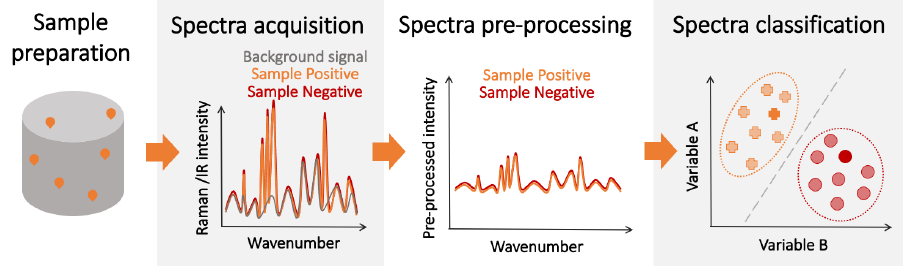
Figure 3. An example of the detection process for a spectroscopy-based detector. After sample collection, the sample is prepared to be analyzed. This preparation, which can be minimal, depends on the spectroscopic technique, type of sample, and probing mechanism. The prepared sample is measured, and its spectrum is obtained. The spectrum is then classified as positive or negative depending on the pre-build classification model. Oftentimes, pre-processing (e.g., background subtraction) of the raw spectrum is necessary. The final outcome is a decision (i.e., positive/negative), which depends on an pre-established